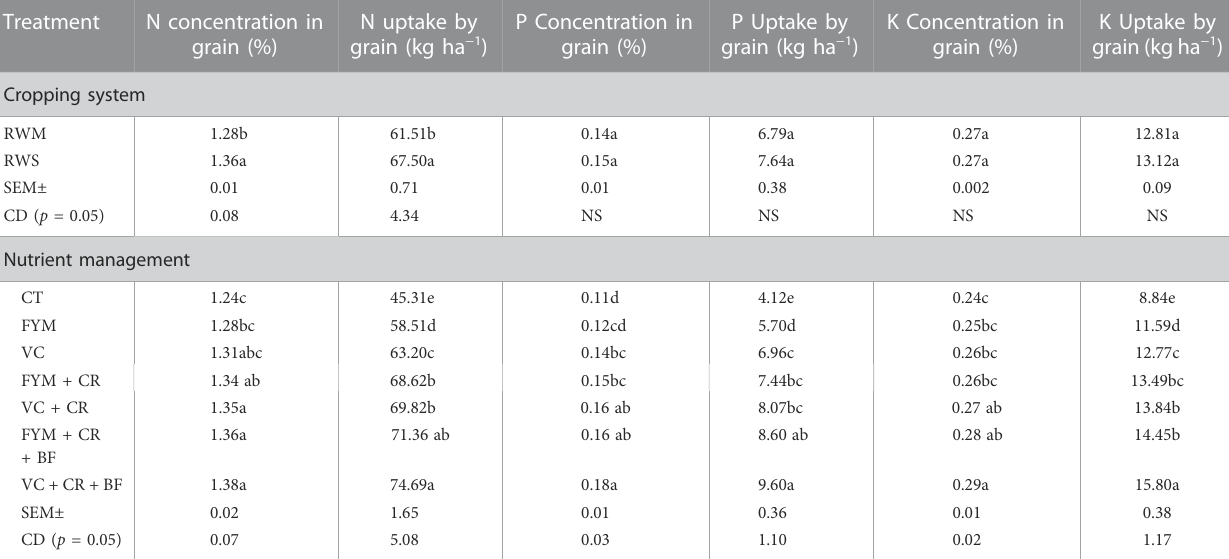
TABLE 3 Long-term effect of cropping systems and organic nutrient management on N, P, and K concentrations and their uptake by rice grain. Treatment N concentration in grain